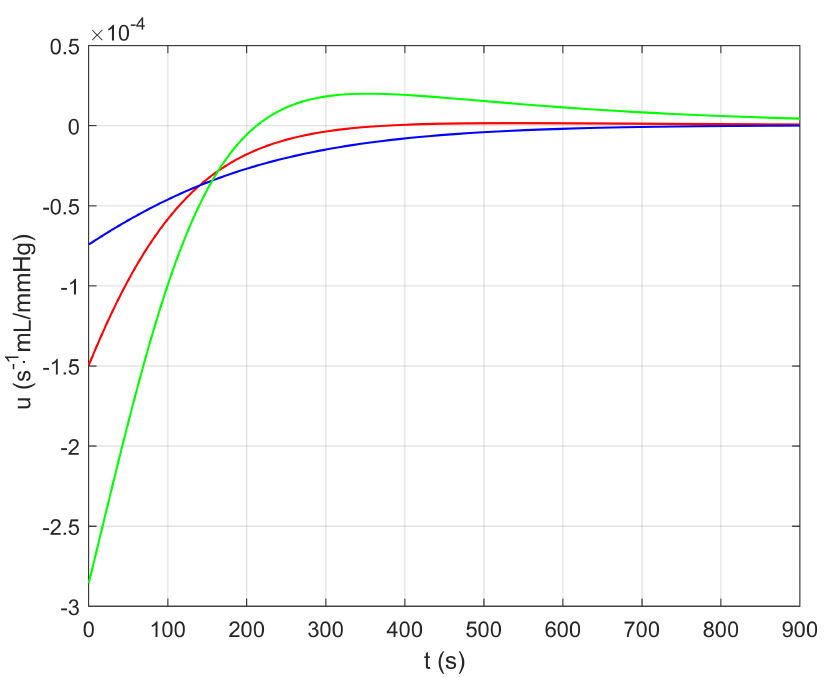
Figure 5. Control input (arterial–arteriolar compliance rate) versus time (solid red line for κ 1 = 0.002, κ 2 = 0.01, M 1 = 0.1738, M 2 = 3.46 × 10 − 4 ; solid blue line for κ 1 = 0.002, κ 2 = 0.005, M 1 = 0.1738, M 2 = 3.46 × 10 − 4 ; solid green line for κ 1 = 0.003, κ 2 = 0.01, M 1 = 0.1738, M 2 = 5.19 × 10 − 4 ).